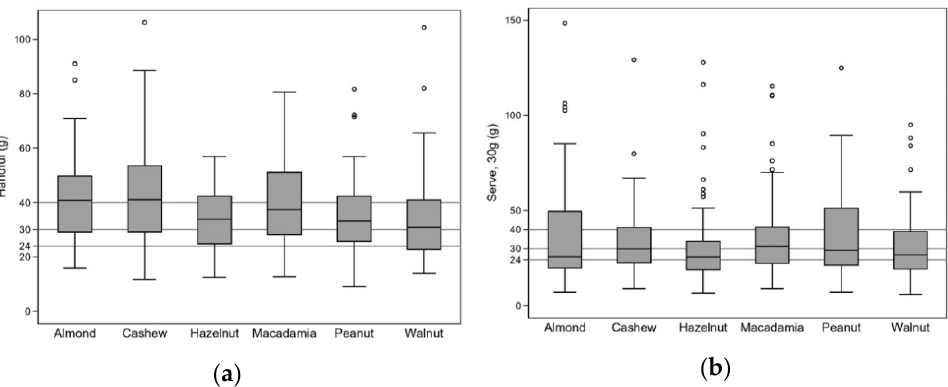
Figure 1. The distribution of portion size chosen, with lines depicting 24 g, 30 g and 40 g, when asked to select: ( a ) a handful; ( b ) an estimated 30 g serving. Hollow circles ( ◦ ) indicate outliers (here defined as more than 1.5 IQR from the nearest quartile). Table 3. Percentage of participants selecting at least 80% of the recommended intake (30 g) for the different portion measures. Nut Type Usual Serving